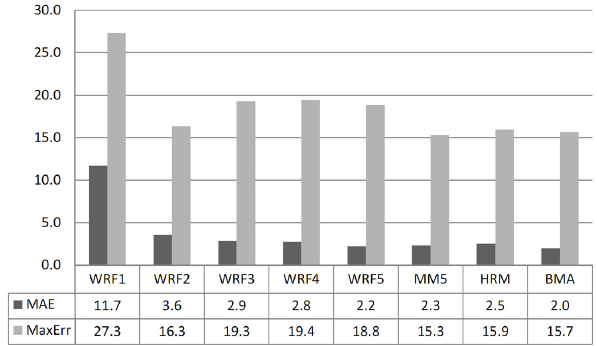
Fig. 5. Minimum Absolute Error (MAE) and maximum error for all ensemble members and calibrated BMA outputs.